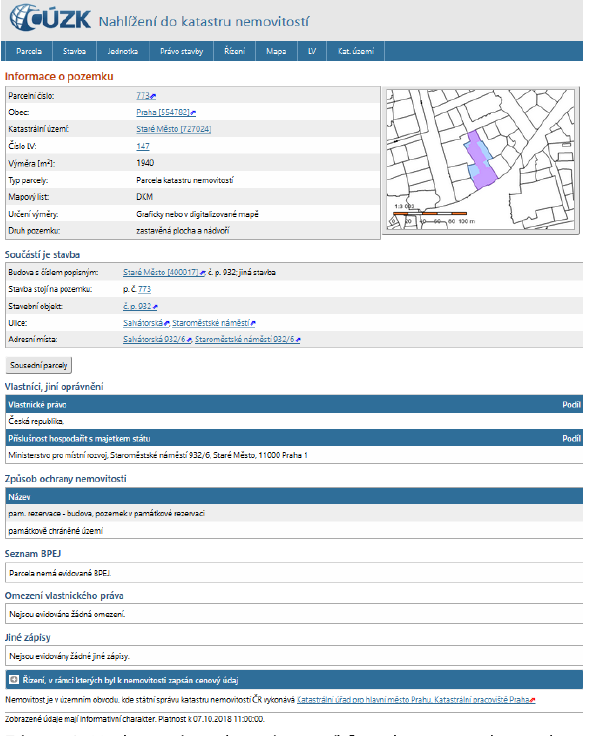
Figure 2. Web service where is possible to browse cadastre data in the Czech Republic. (ČÚZK, 2018)